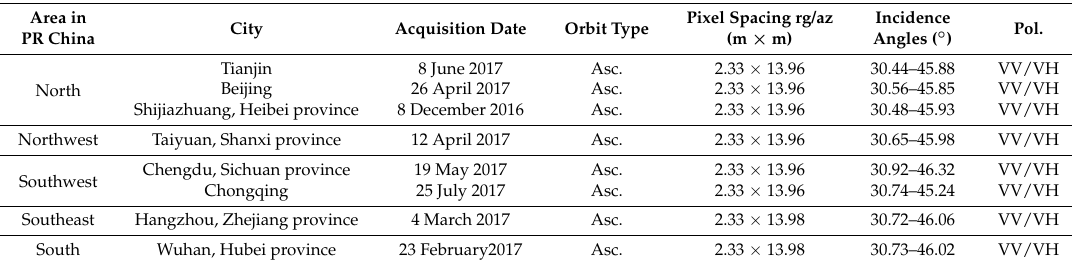
Table 1. Sentinel-1 SAR data characteristics for study